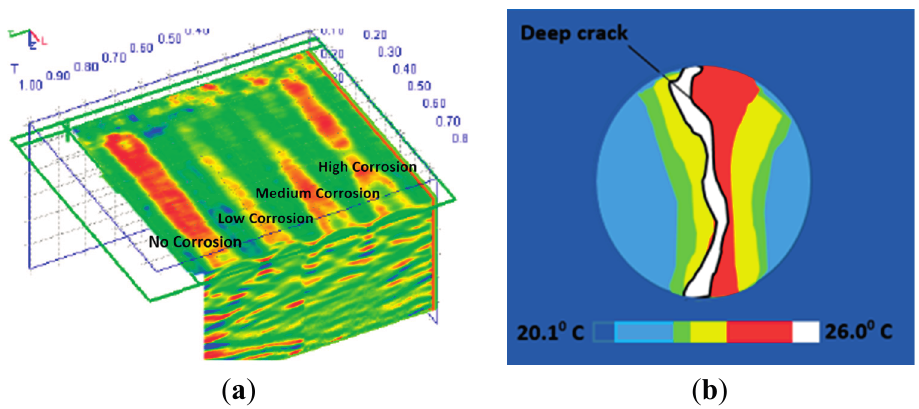
Figure 2. ( a ) 3D image of GPR of concrete slab with different level of steel corrosion, unit (m) (with permission from [68]) and ( b ) IRT image of concrete surface of cylinder, unit (°C) (Reproduced and modified from